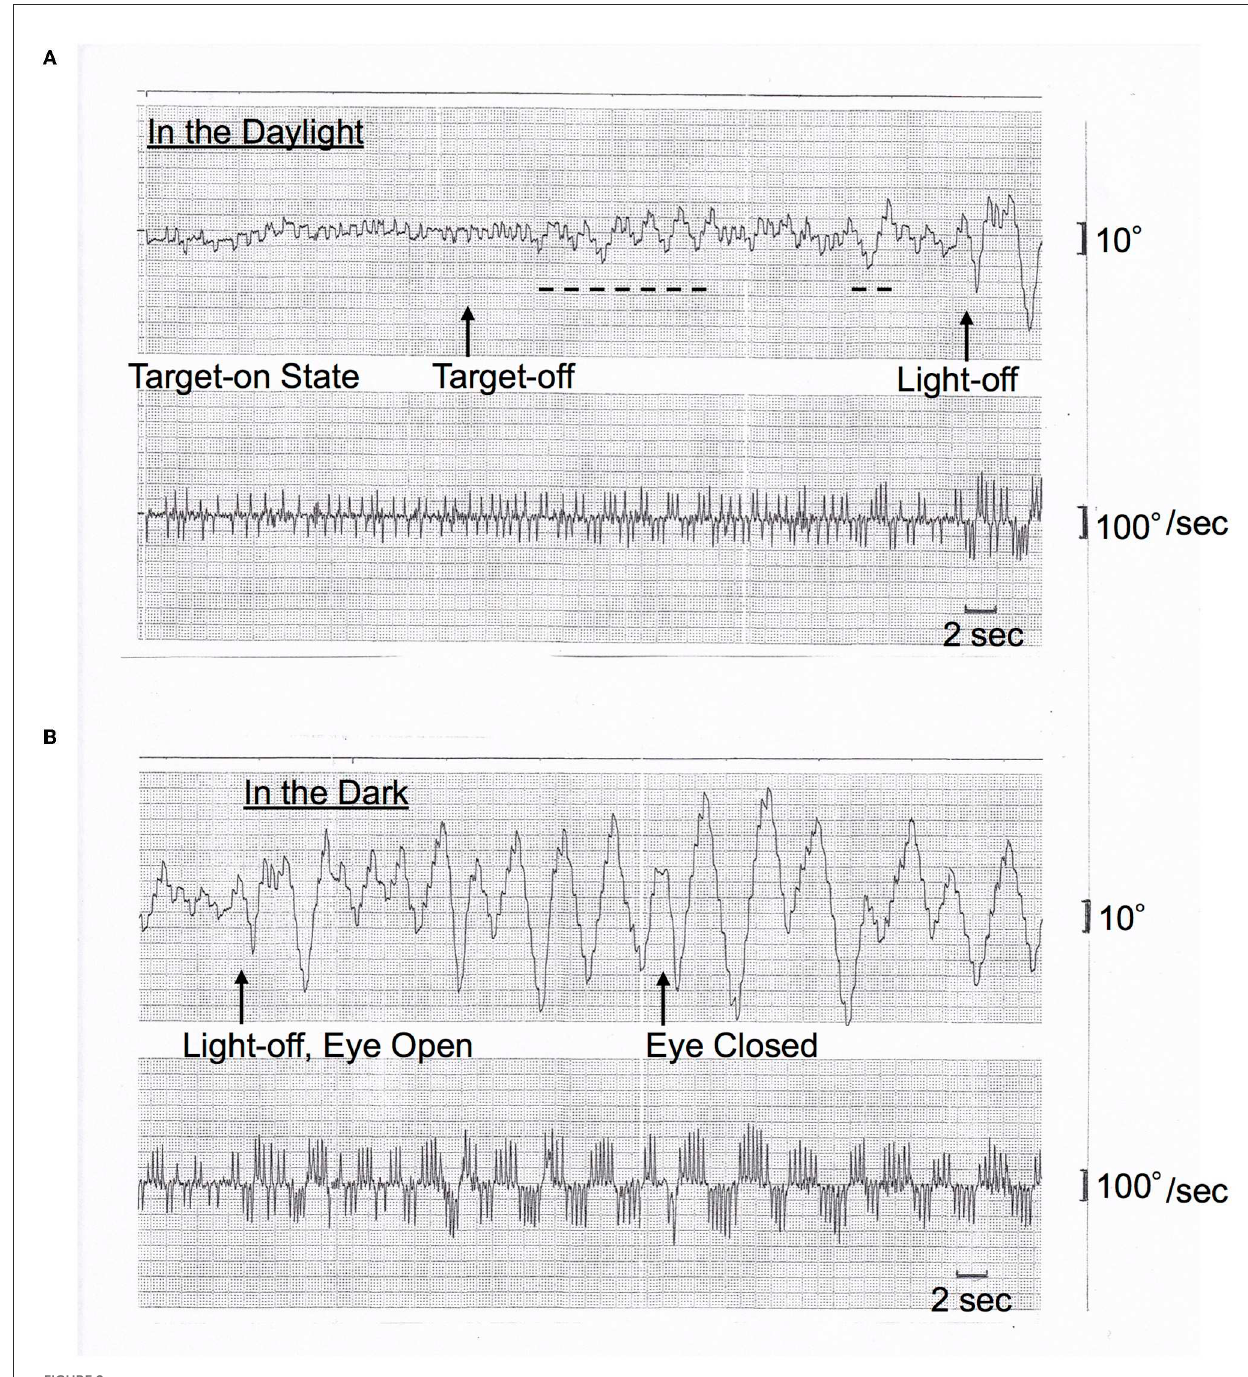
FIGURE2 (A , B) Horizontal AC-EOG recordings. In each figure, the upper graph shows semi-eye position (time constant 3s) and the lower graph shows eye speed (time constant 0.03s). In each graph, the upper direction indicates rightward eye movement, and the lower direction indicates leftward. The chart speed is 5 mm/s. This figure was recorded one and a half years after Figure 1. (A) In the daylight, macro SWJs (5 deg) occurred under the target-on state from the start, and then under the target-off state, a single or several SPPGs with small amplitude (15–20 deg) occurred (dashed lines, 15 deg) alternately with macro SWJs. Subsequently, the light was turned off [ (A) continues to (B) ]. (B) In the dark, macro SWJs soon disappeared. Alternatively, SPPG appeared continuously and got larger (to 50 deg) than in the daylight. And then, with eyes closed, giant SPPG emerged with an amplitude of 70 deg, reaching the full